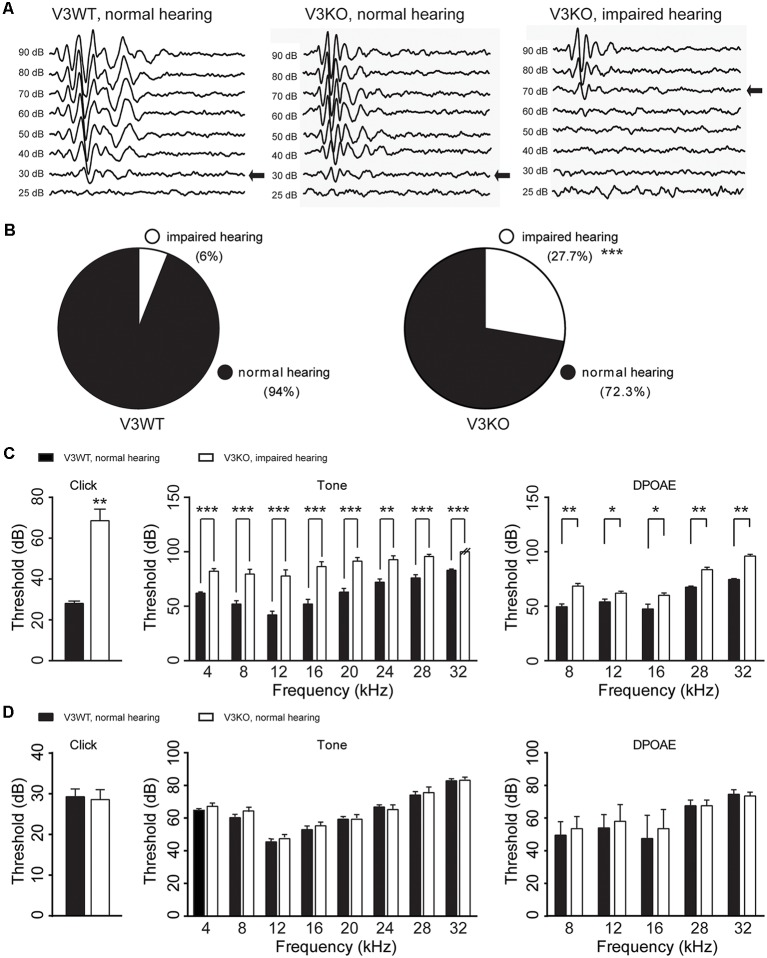
Hearing in V3WT and V3KO mice. (A) Representative auditory thresholds (bold arrow) were measured in V3WT (left) and V3KO mice with normal hearing (middle) and V3KO mice with impaired hearing (right). (B) The proportion of mice with impaired (open circle) and normal (solid circle) hearing in the V3WT (left) and V3KO (right) groups. (C) Auditory brainstem response (ABR) thresholds in response to broadband clicks (left) and 3-ms pure tones of 4, 8, 12, 16, 20, 24, 28, and 32 kHz (middle) and DPOAE thresholds (right) measured in V3WT mice with normal hearing (solid bar) and V3KO mice with impaired hearing (open bar). (D) Click (left), tone (middle), and DPOAE (right) thresholds measured in V3WT (solid bar) and V3KO mice both with normal hearing (open bar). Data are shown as mean ± SEM (n = 10 per group). *P < 0.05, **P < 0.01, ***P < 0.001.